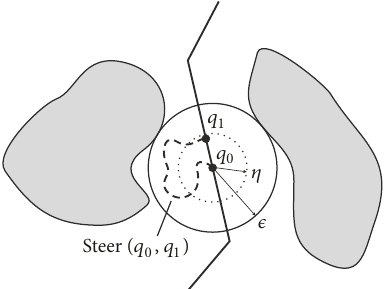
Figure 17: Illustration of topological property for C = R 2